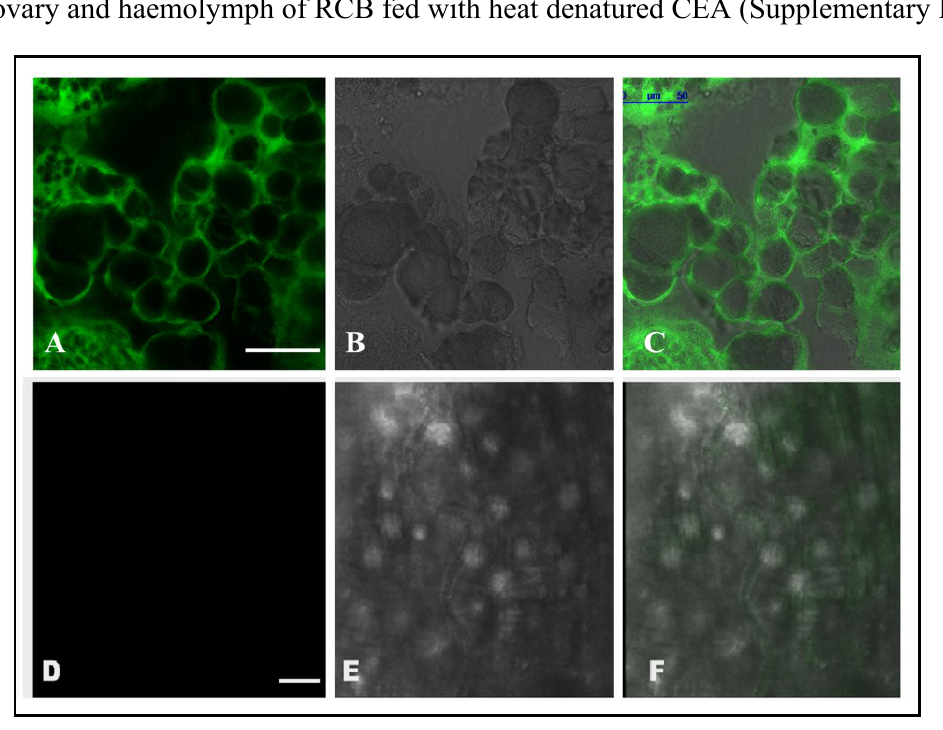
Figure 1. Confocal microscopic images showing the binding of CEA to the midgut epithelial cells of RCB. ( A )—Fluorescence image showing binding of CEA to midgut epithelial cells of insects fed with CEA supplemented diet; ( B )—Phase contrast image; ( C )—Merged image of ( A ) and ( B ); ( D )—Negative control where gut of control diet fed insects was used for analysis; ( E )—Phase contrast image; ( F )—Merged image of ( D , E ). (Bar indicates 50 μm).